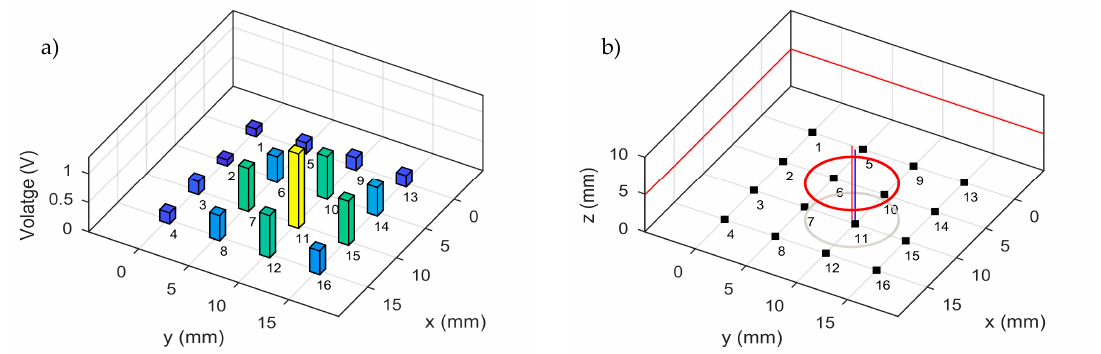
Figure 4. ( a ) Voltage readouts from each sensor during one static trial. ( b ) The calculated magnet position (red) compared to the actual magnet position